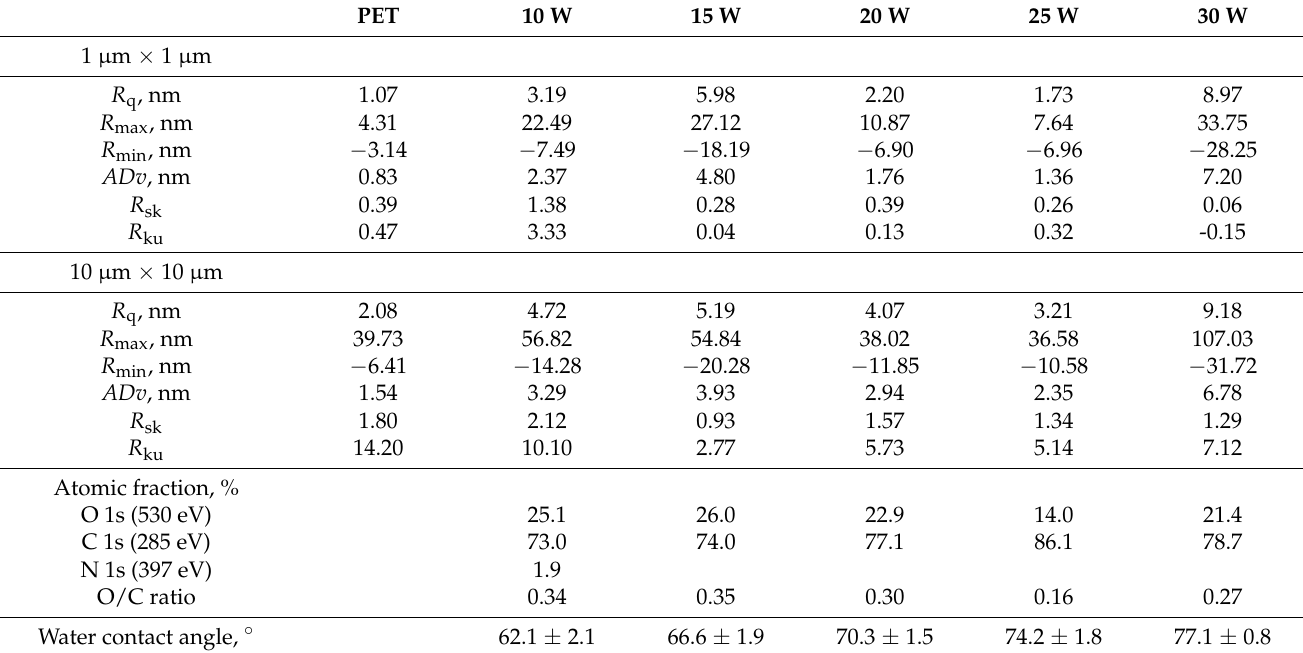
Table 1. Roughness characteristics, atomic fraction and chemical states of elements present in top surface layer of polymer coatings deposited on the surface of PET substrata. PET 10